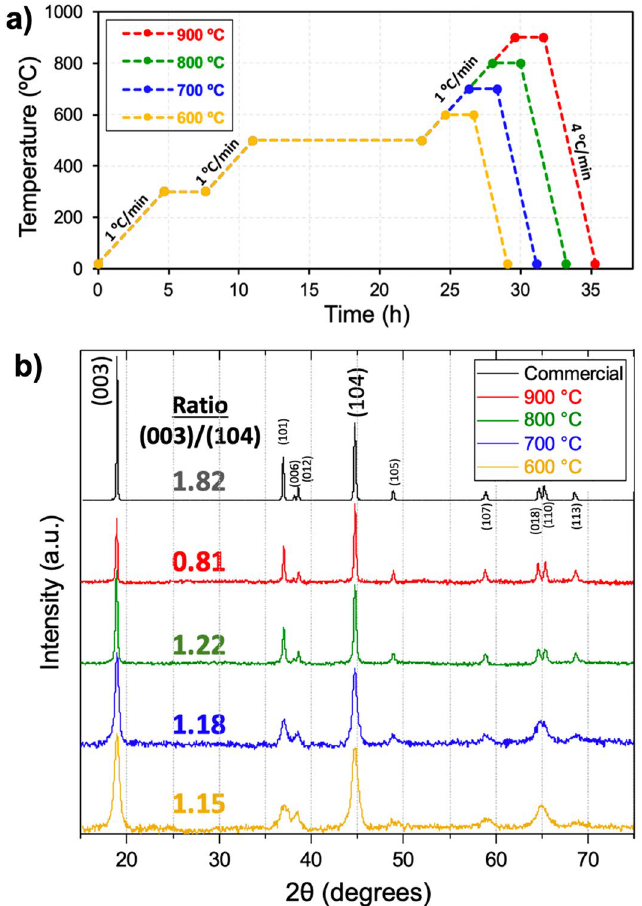
Figure 3. ( a ) Temperature profile used to synthesize NMC 111 from the composite polymer matrix. ( b ) XRD diffractograms of the four NMC 111 materials synthesized at a maximum temperature of 600, 700, 800 and 900 °C, and a commercial sample. The written ratios correspond to the intensity ratio of reflections